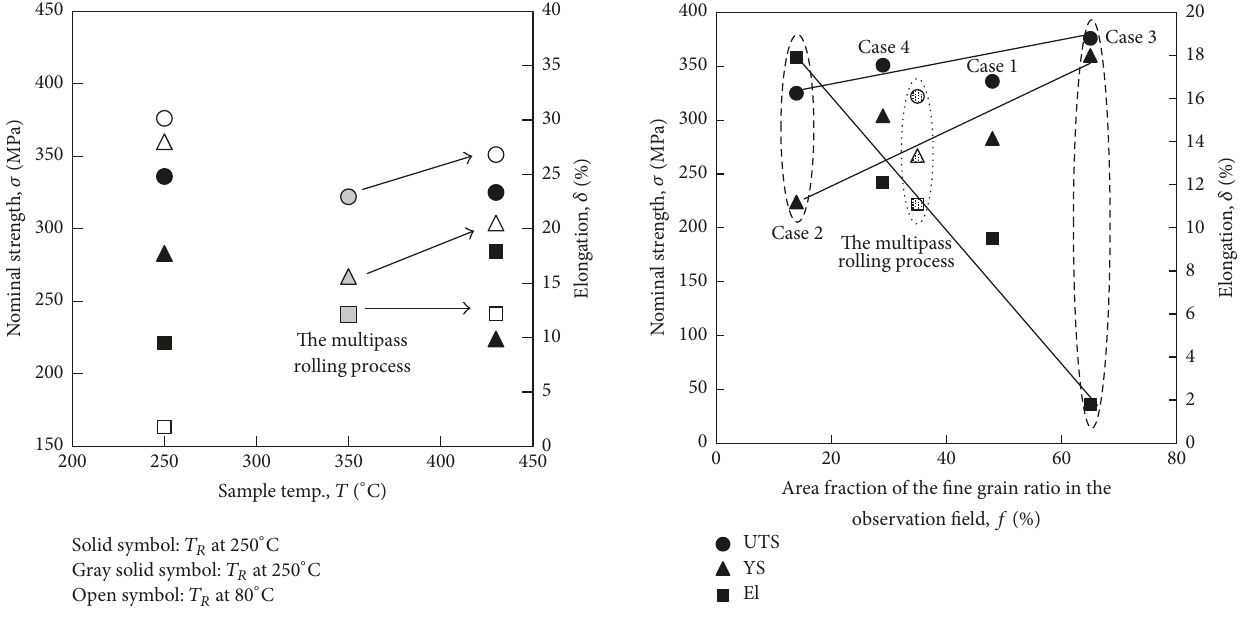
Figure 5: Relationship between the sample temperature and the mechanical properties of case 1 to case 4 and the multipass rolling process result (Section 3.2). The circle, triangle, and square symbols represent UTS, YS, and El, respectively.